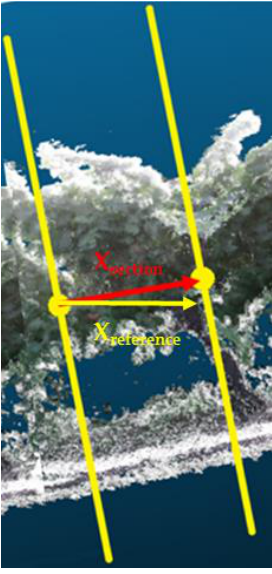
Figure 8. The X-axis of the section (Xsection) is represented in red, and the X-axis of the reference (Xreference) is represented in yellow.